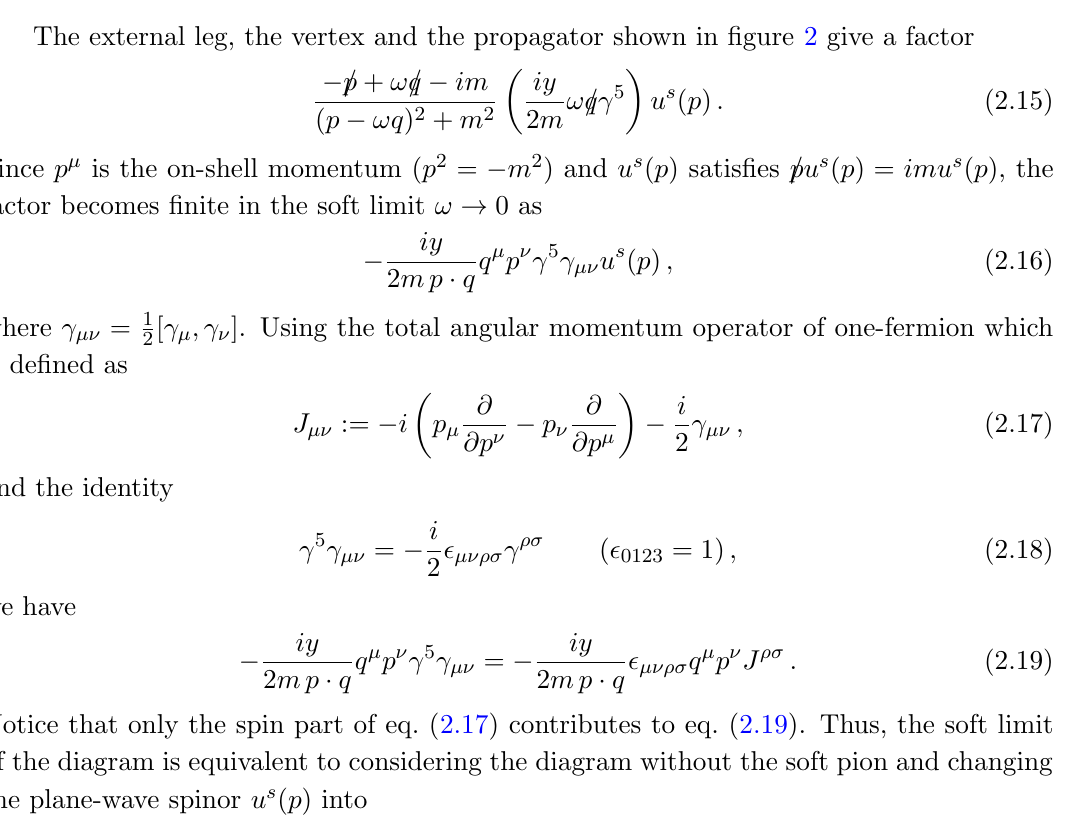
Figure 2 . A part of a diagram relevant to the soft limit. The circle represents the other part of the diagram. The momentum p (cid:22) !q (cid:22) approaches to on-shell in the soft limit ! (cid:0)